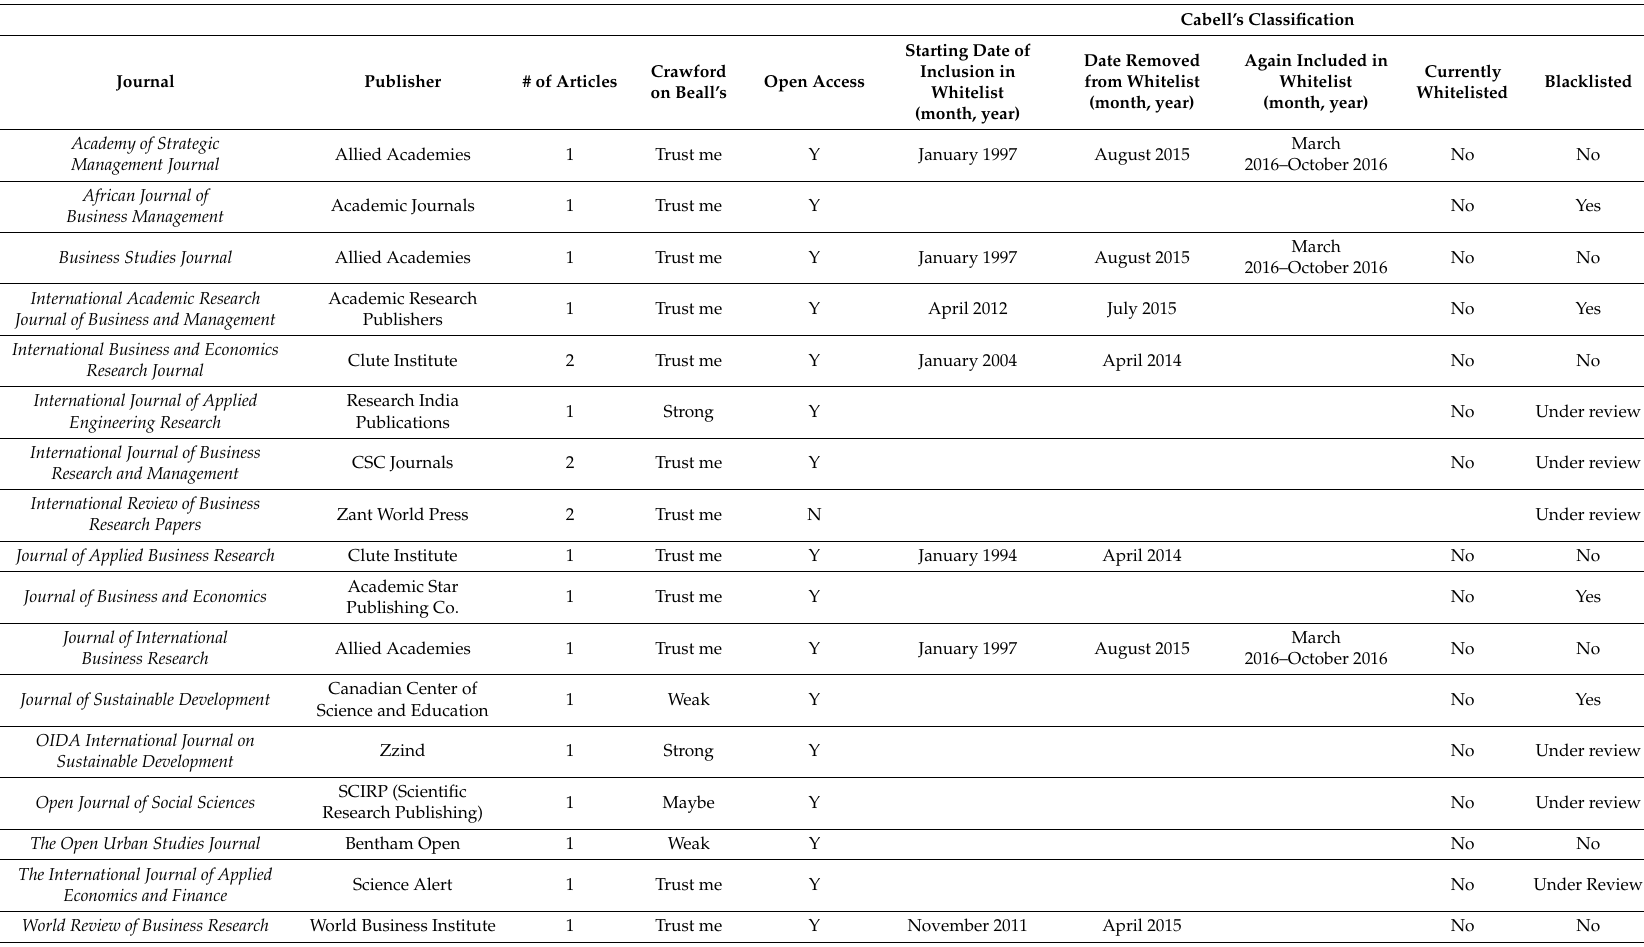
Table 3. Publications of research faculty members in Beall’s 2016 lists and unranked in the 2013 ABDC